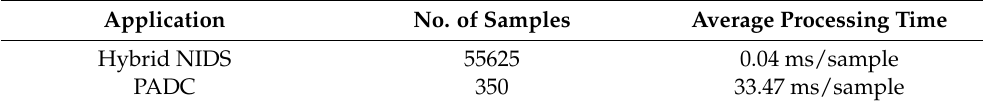
Table 6. Average processing time for the hybrid NIDS and PADC application.